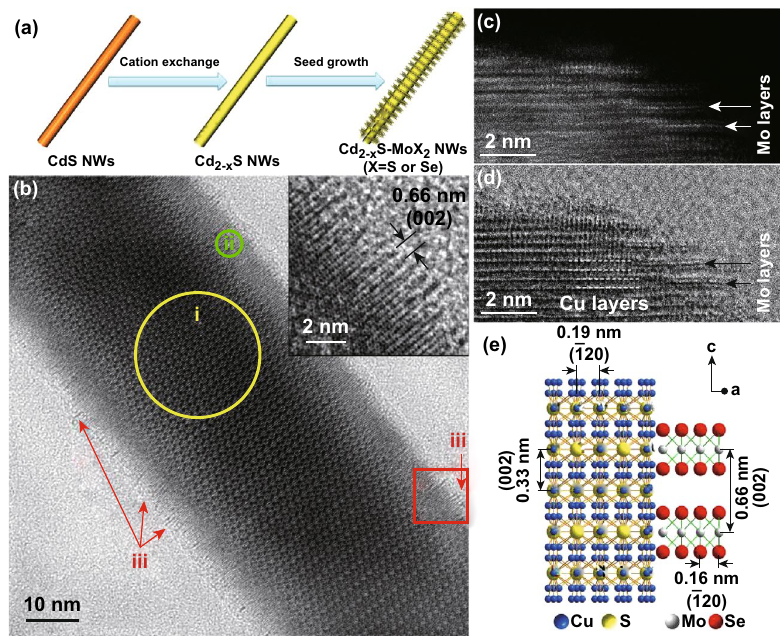
Fig. 5 a Schematic illustration of the synthesis of Cu 2‑ x S‑MoX 2 (X = S or Se) epitaxial heterostructure. b TEM image of a Cu 2‑ x S‑MoSe 2 het‑ erostructure. The circles indicate the Cu 1.94 S (component i) and Cu 2 S (component ii). The red arrows indicate the MoSe 2 (component iii). Inset: HRTEM image of Cu 2‑ x S‑MoSe 2 taken in the square in ( b ). c HAADF‑STEM and d annular bright‑field STEM images of a Cu 2‑ x S‑MoSe 2 heter‑ ostructure taken at the same area. e Schematic illustration of the crystal structure of Cu 2‑ x S‑MoSe 2 heterostructure. Reproduced with